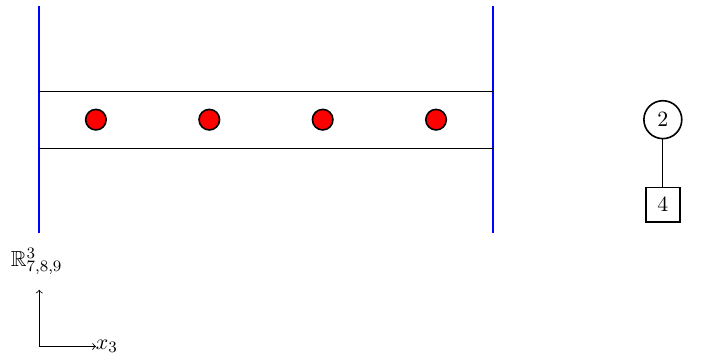
Figure 8 . The figure on the left shows the Type IIB brane construction for the linear quiver on the right. The red nodes represent D5 branes, the horizontal black lines are D3 branes, and the vertical blue lines represent NS5 branes.